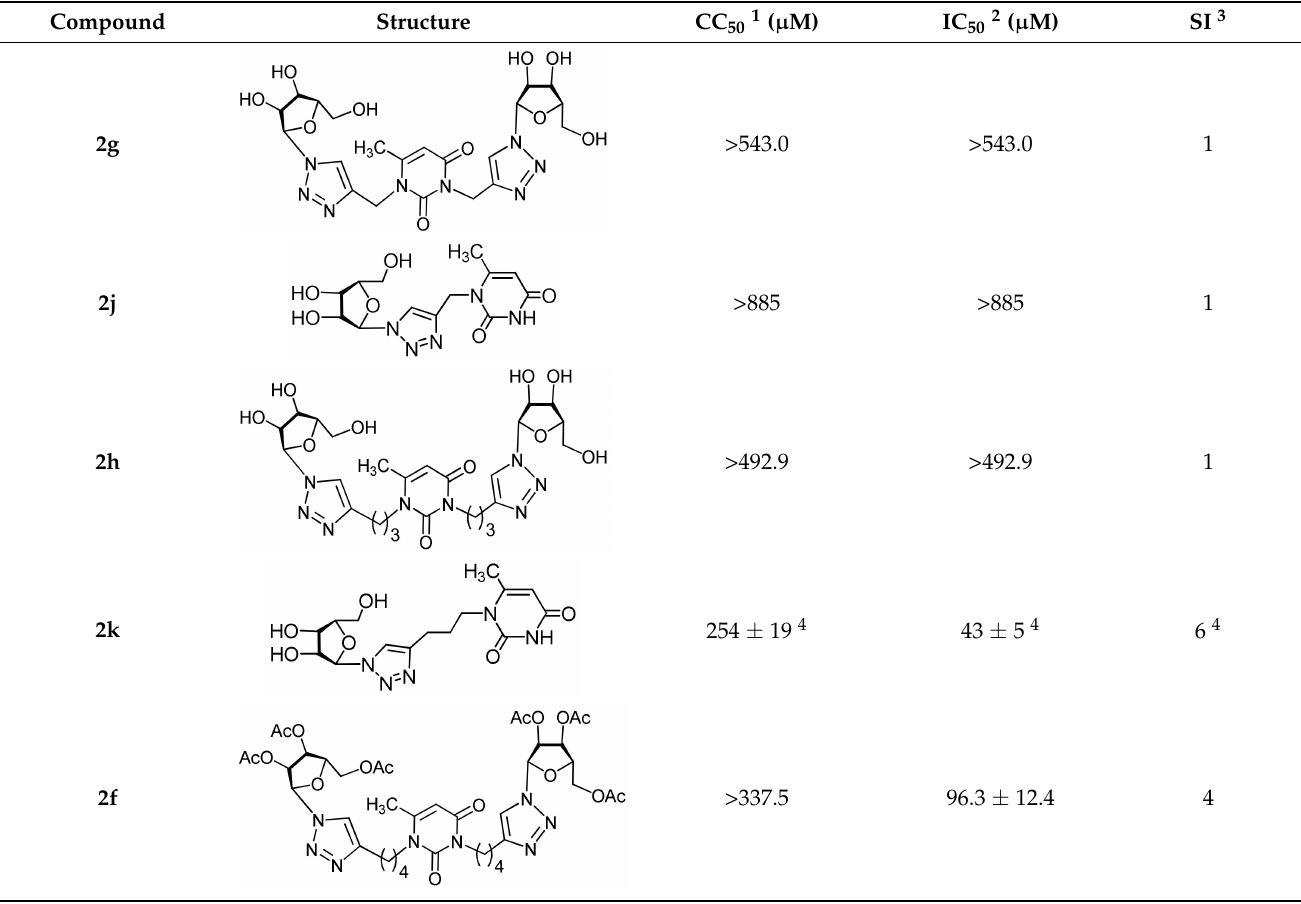
Table 1. Antiviral activity against A/Puerto Rico/8/34 (H1N1) influenza virus and cytotoxicity of 1,2,3-triazolyl nucleoside analogues synthesized in this study and earlier ones